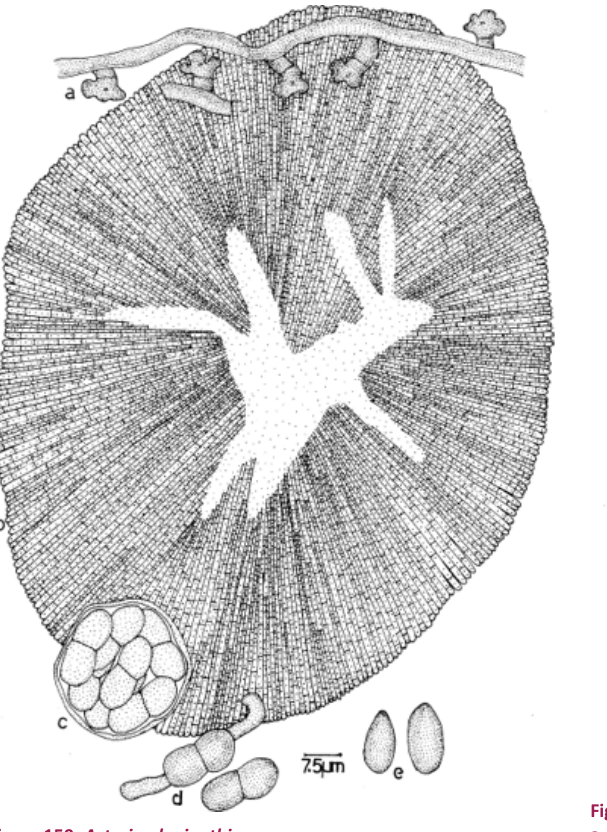
Figure 150. Asterina lepianthis a - Appressorium; b - Thyriothecium; c - Ascus; d - Ascospores